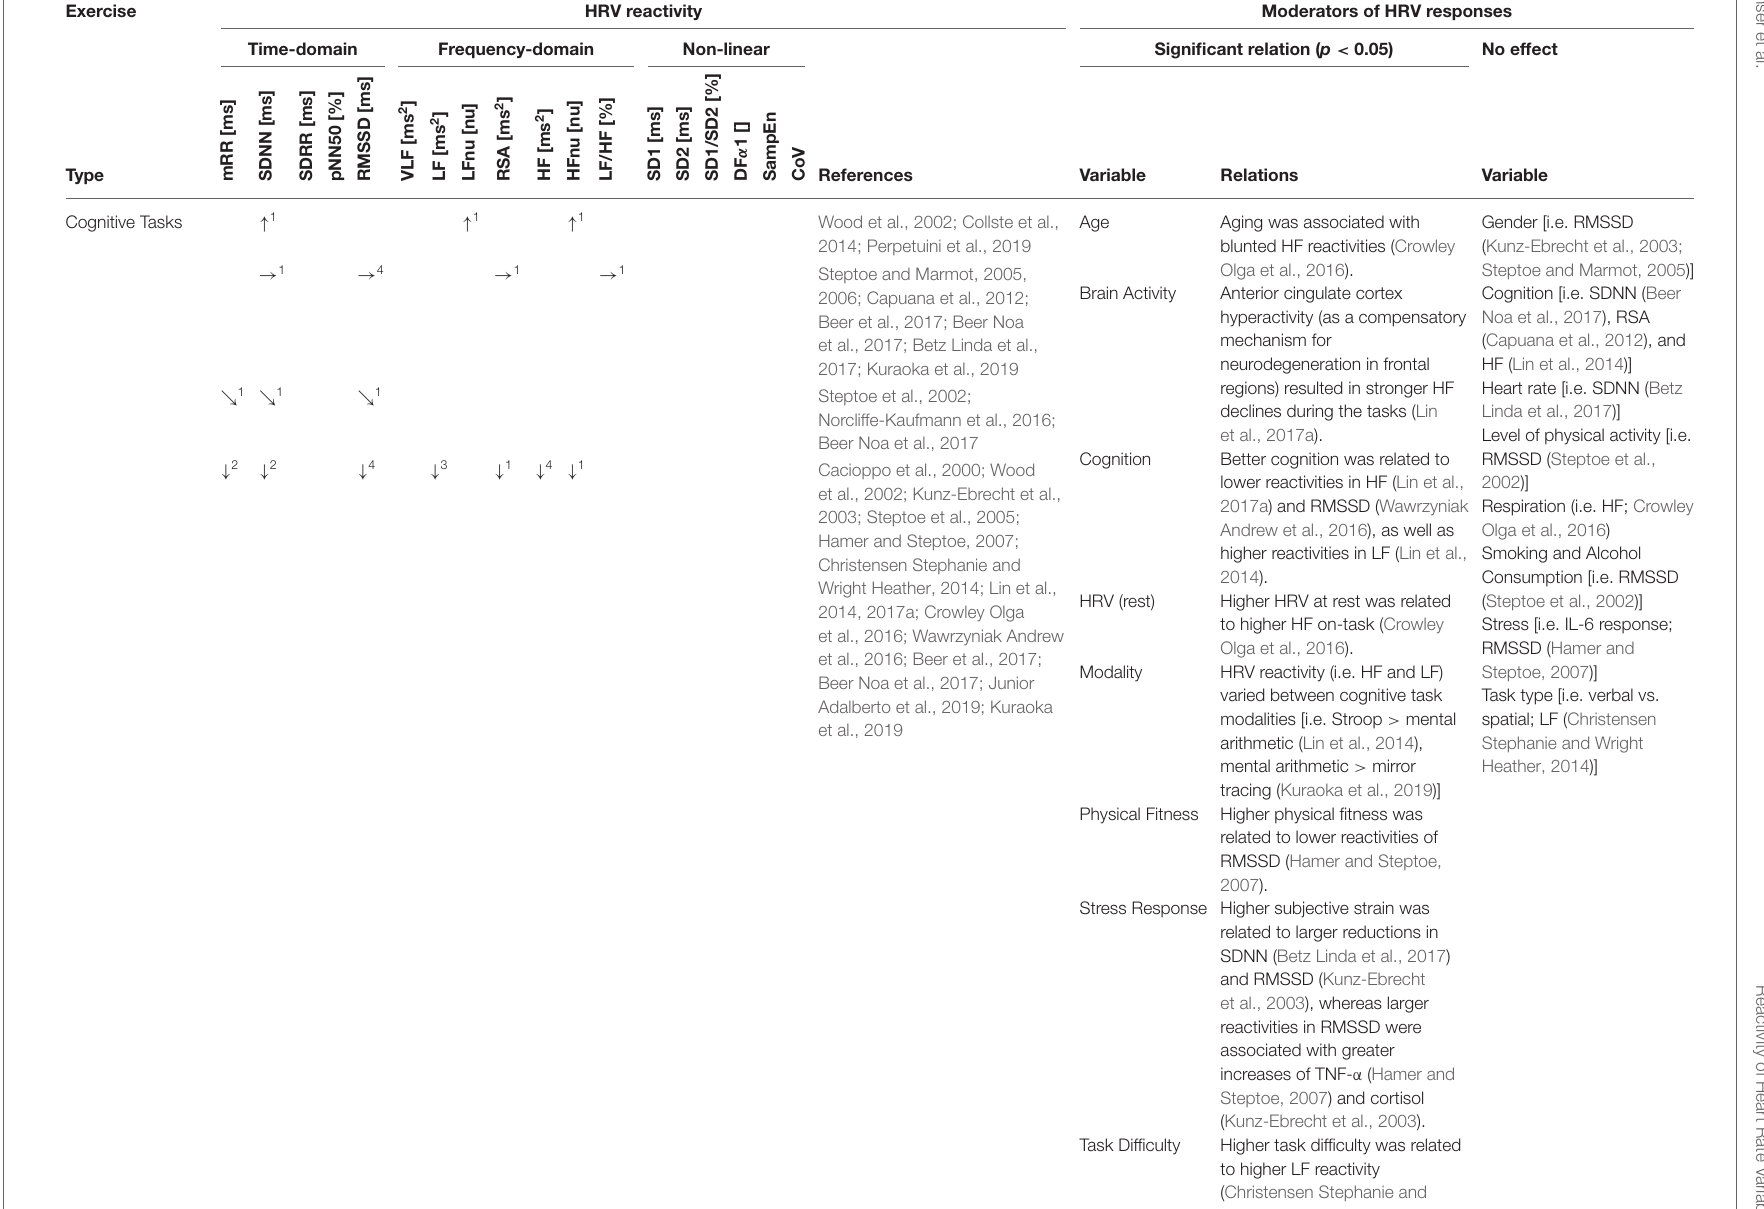
TABLE 2 | Summary table of HRV reactivity and its moderators in healthy middle-aged to older adults ( ≥ 50 years).